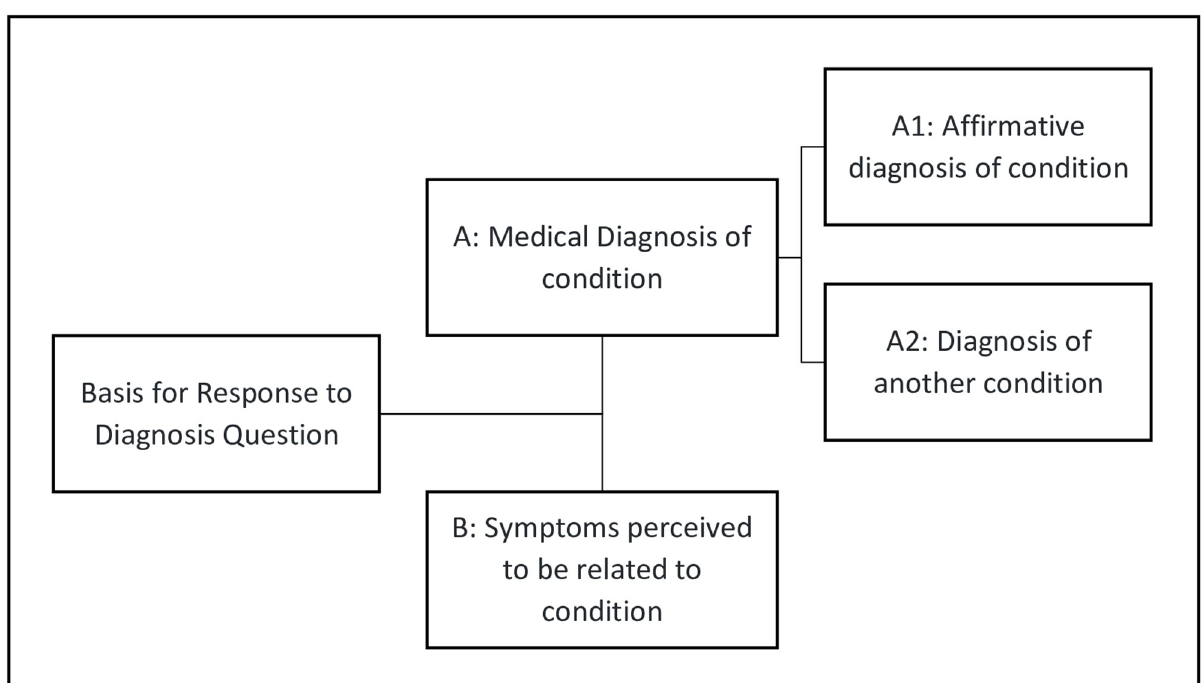
Fig 1. Respondent cognitive pattern for health condition